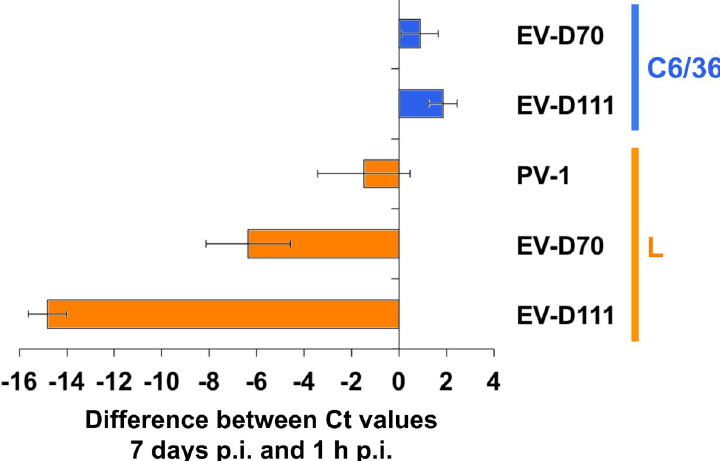
Fig 10. Detection of virus replication in L and C6/C6 cells. PV-1 strain Sabin, EV-D70 strain J670/71 and EV-D111 strain OUP-05-059 suspensions were used to inoculate L cell monolayers; C6/36 monolayers were inoculated with EV-D70 and EV-D111 only. RNA was extracted from clarified supernatant 1 hour post-inoculation and 7 days post- inoculation and EV RNA was detected through real-time RT-PCR. Virus replication leads to an increase of the viral RNA concentration during the course of time and to a drop of cycle threshold (Ct) values. Therefore, negative values on x-axis reveal virus